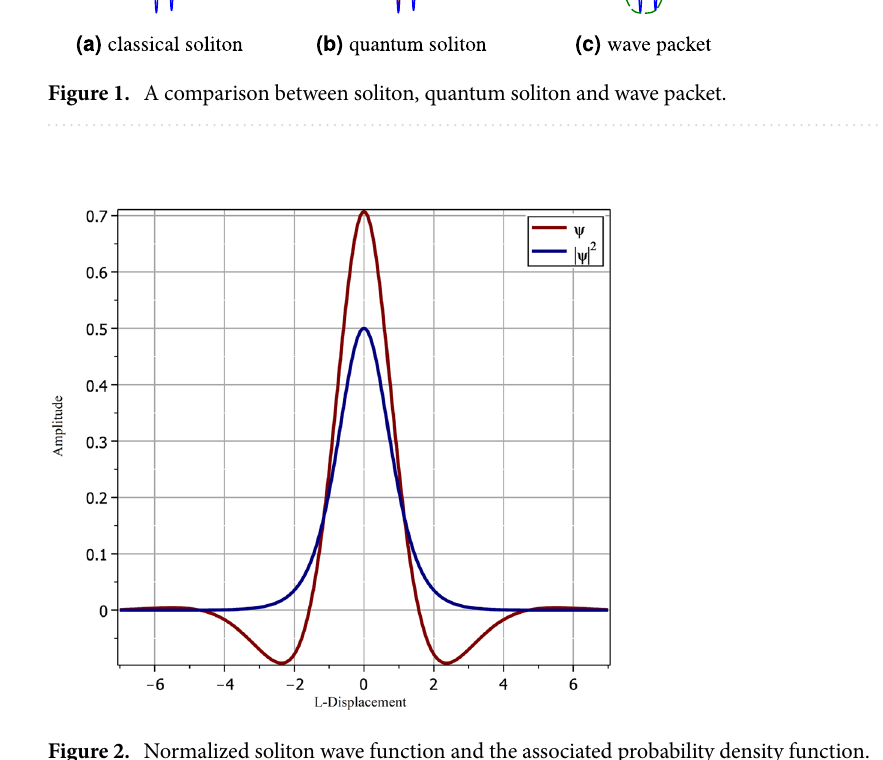
Figure 2. Normalized soliton wave function and the associated probability density